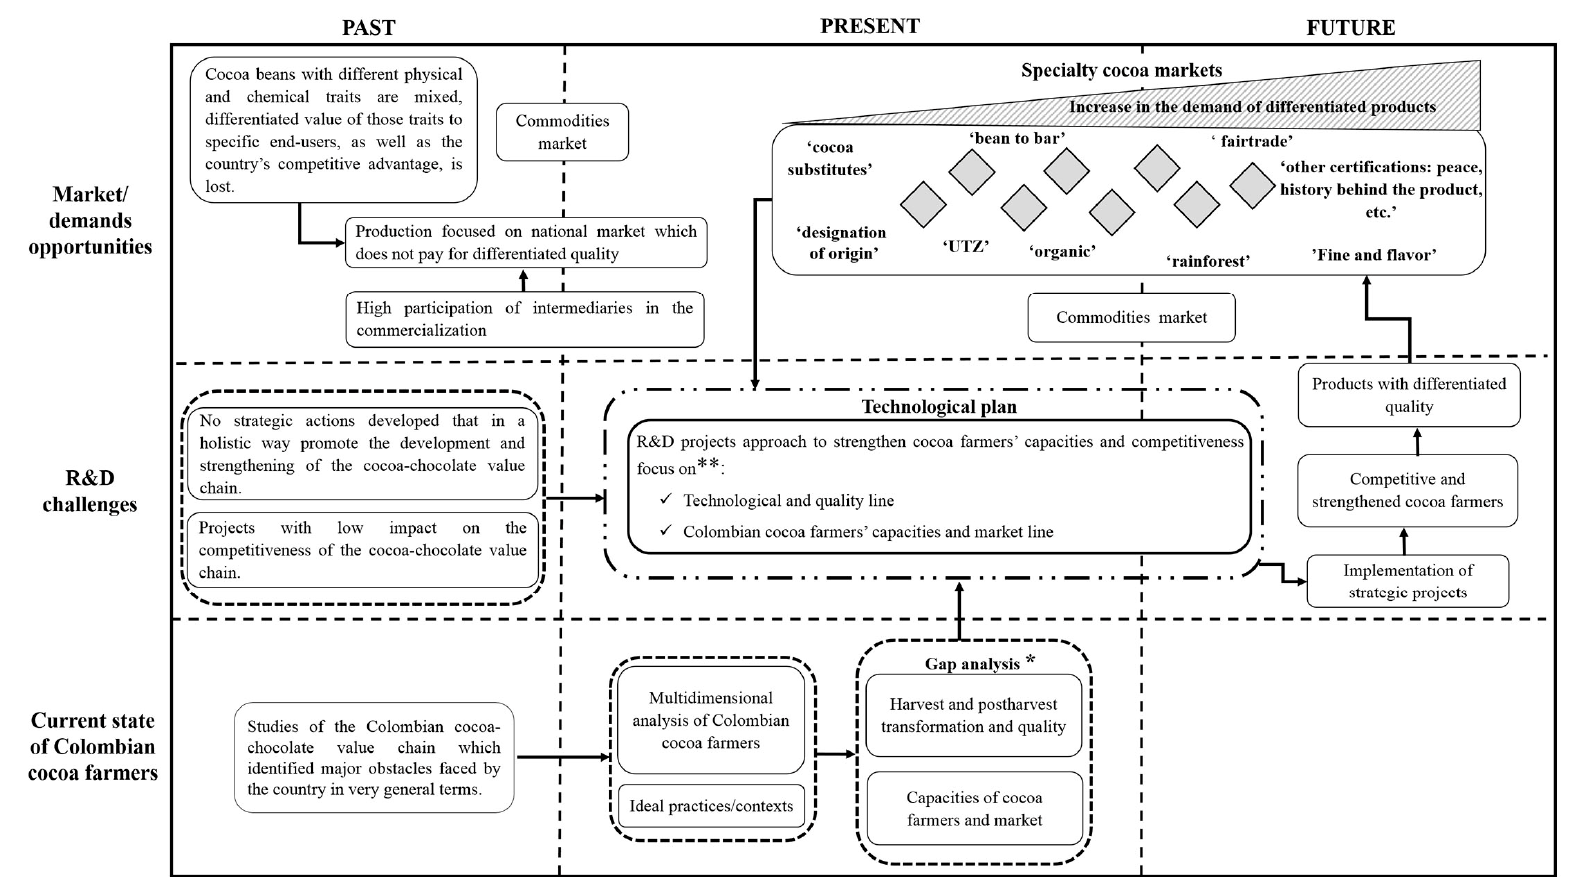
Figure 11. Strategic roadmap of the Colombian cocoa sector. * The gap analysis and ** R&D proposals considered in Section 3. The implementation of these projects considers participatory innovation and transfer plans and the ex-ante, during, and ex-post impact evaluation of the projects in both lines.